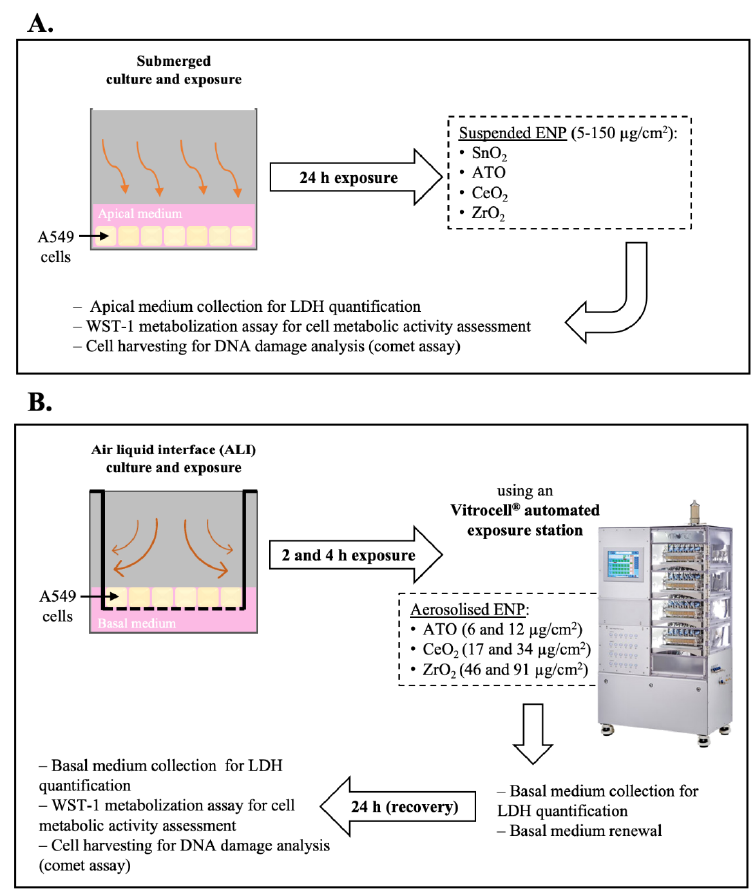
Figure 2. Experimental protocol scheme. ( A ) Human alveolar epithelial cultures under submerged conditions were exposed for 24 h to the tested engineered nanoparticles (ENP) dispersed in serum- free incubation medium. ( B ) Cell cultures under air-liquid interface (ALI) conditions were exposed to either clean air or ENP aerosols using an Automated Exposure Station (AES) for 2 and 4 h to achieve different deposited doses. It was not possible to generate a stable aerosol from SnO 2 NP, though they were not tested under ALI. As depicted, samples for cytotoxicity (LDH release and WST-1 metabolisation) and genotoxicity (DNA damage) assessment were collected at different timepoints.